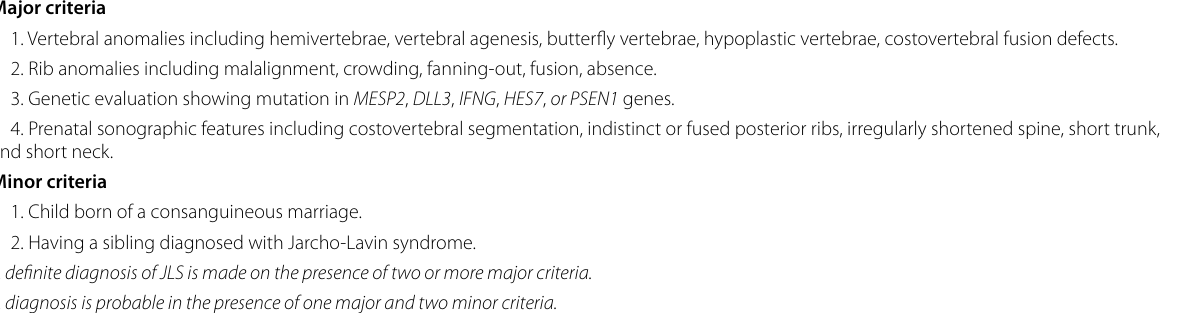
Table 1 Asghar-Zameer criterion for the diagnosis of JLS at birth Major